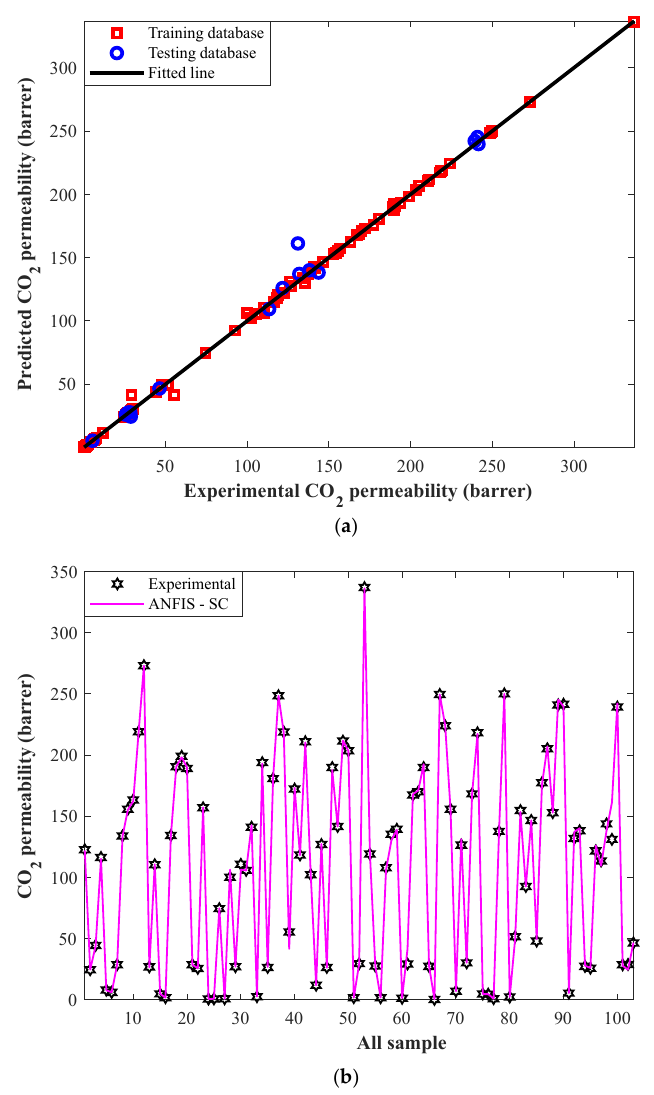
Figure 5. ( a ) Correlation between experimental and predicted CO 2 permeabilities for the whole of experimental databank. ( b ) Experimental CO 2 permeabilities and their associated ANFIS-SC predictions for the combination of training and testing datasets.